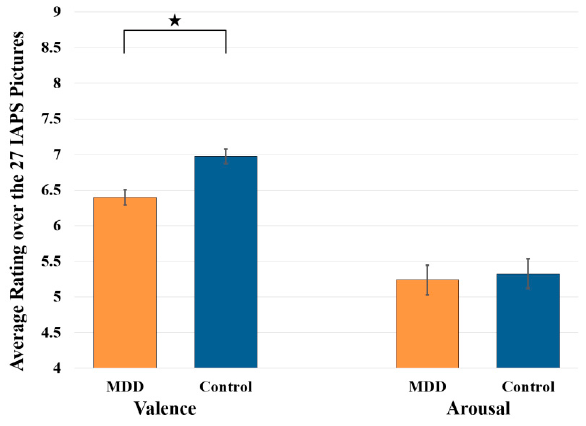
Figure 7. Ratings of emotional valence and arousal for the 27 IAPS pictures. * denotes p <0.05.